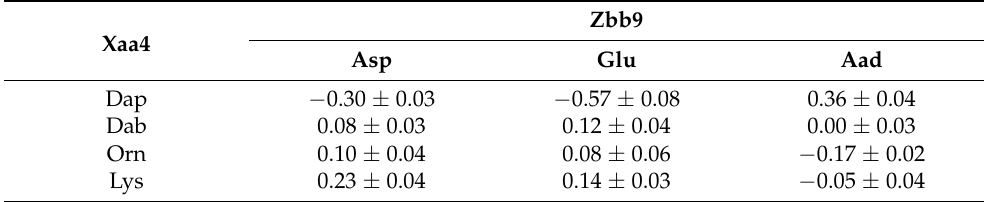
Table 2. The folding free energy ( ∆ G fold , kcal/mol) for the HPTXaaZbb peptides 1